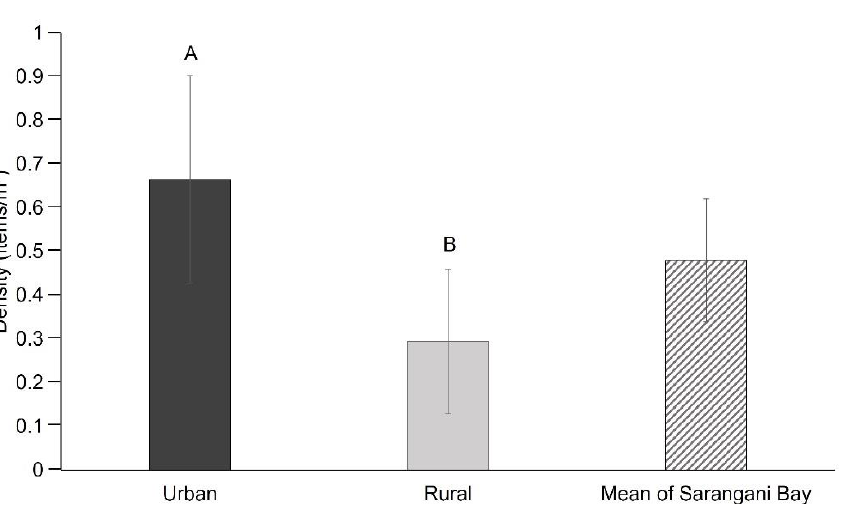
Figure 2. Density of macroplastics sampled from seven rural beaches and seven urban beaches of Sarangani Bay, Philippines. Error bars represent the standard deviation of 14 sampling times. Different letters indicate significant differences ( p < 0.05).